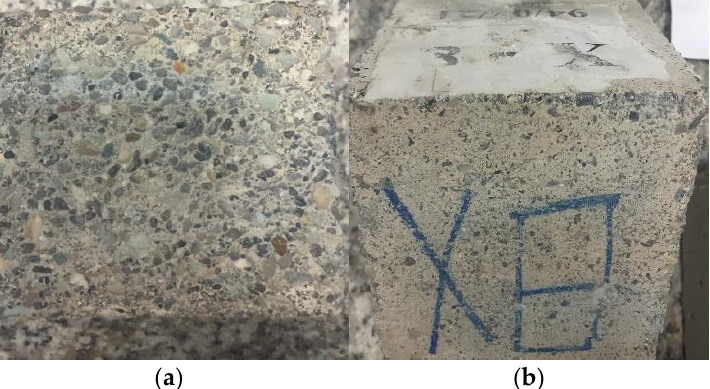
Figure 5. ( a ) KOH and ( b ) NaOH-activated slag concrete specimens exposed to H 2 SO 4 after 6